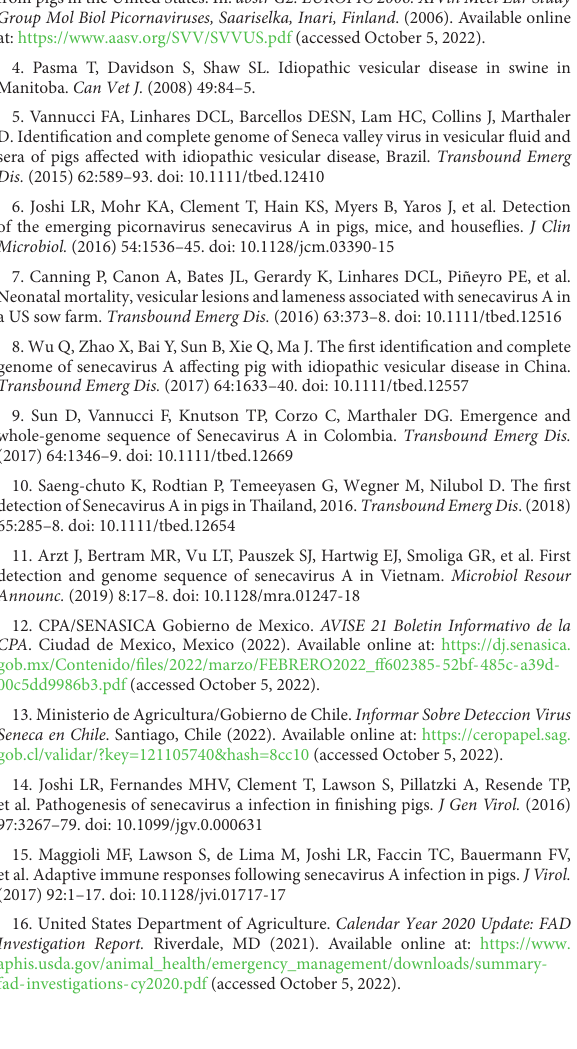
table-egg layer farms in the Midwestern United States, 2015. Avian Dis. (2016) 60:460–6. doi: